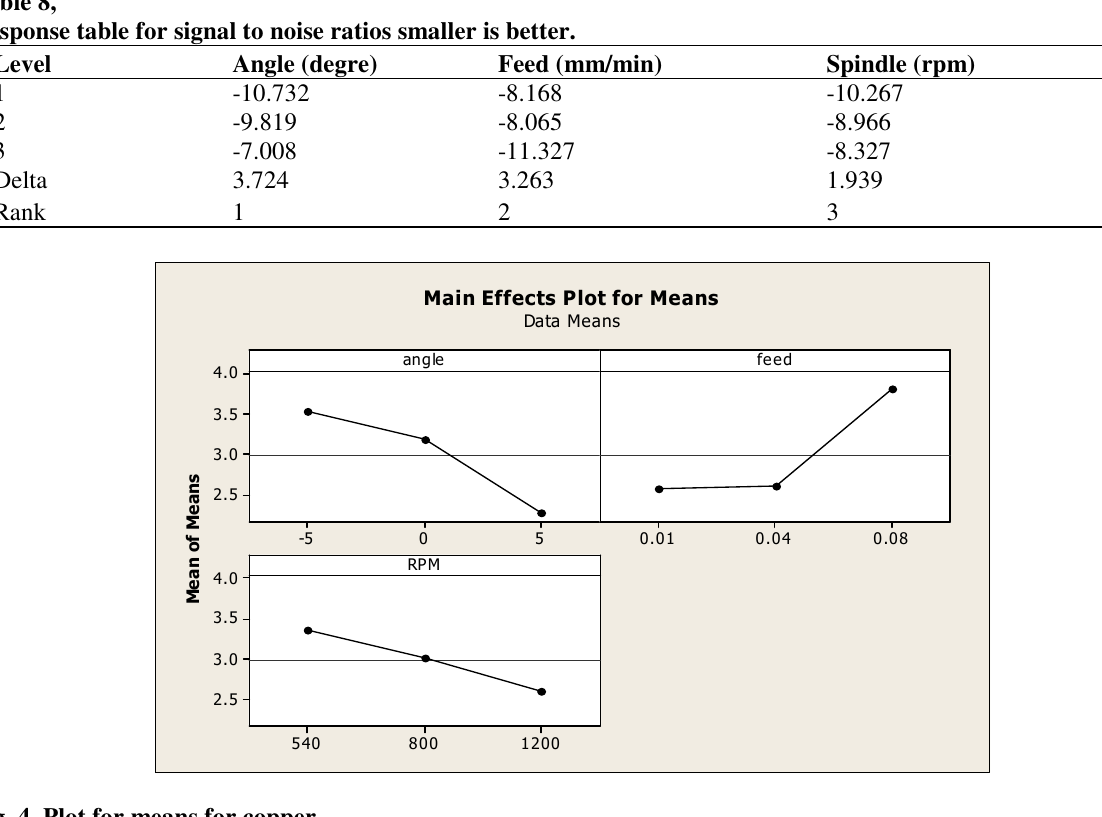
Fig. 4. Plot for means for copper.